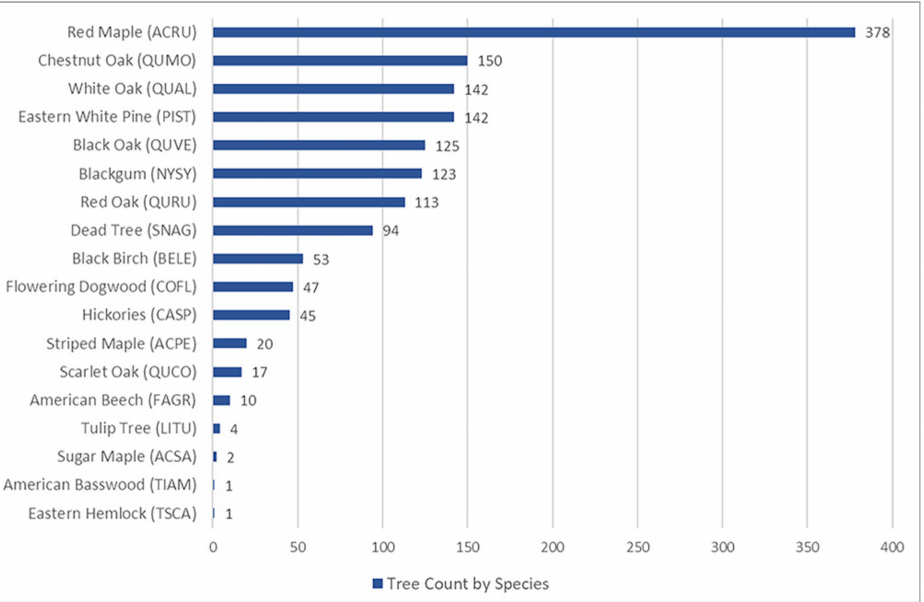
Figure 3. Aggregate tree count by species for the four one-hectare study plots. ACRU— Acer rubrum , QUMO— Quercus montana , QUAL— Q. alba , PIST— Pinus strobus , QUVE— Q. velutina ,